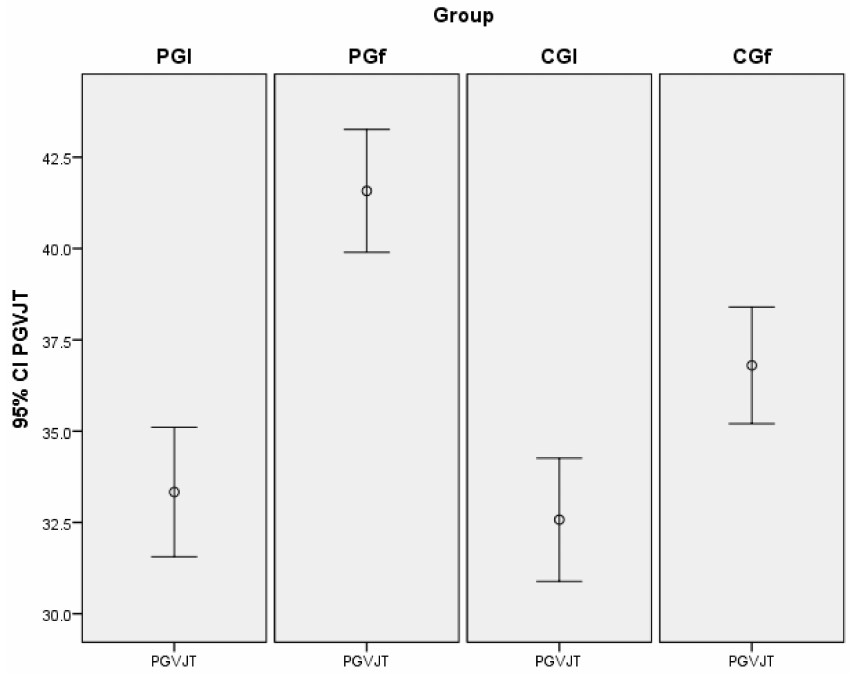
Figure 6. Vertical Jump means between the PG and CG